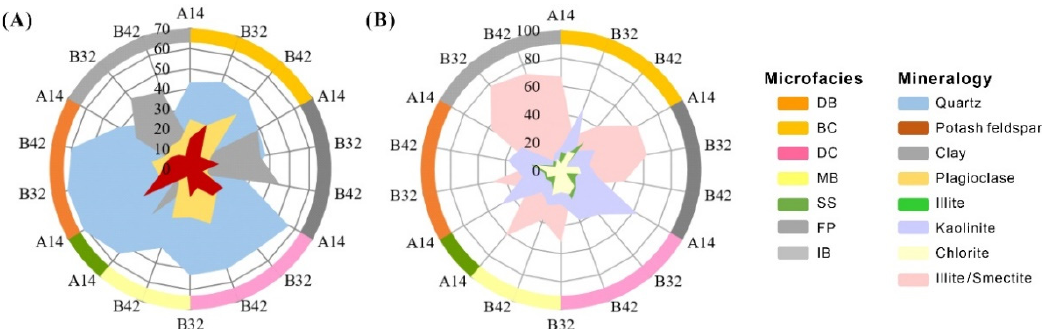
Figure 16. Star diagram shows the mineral distribution characteristics of different sedimentary mi- crofacies. ( A ) X-ray diffraction method. ( B ) The quantitative mineral clay analysis method.